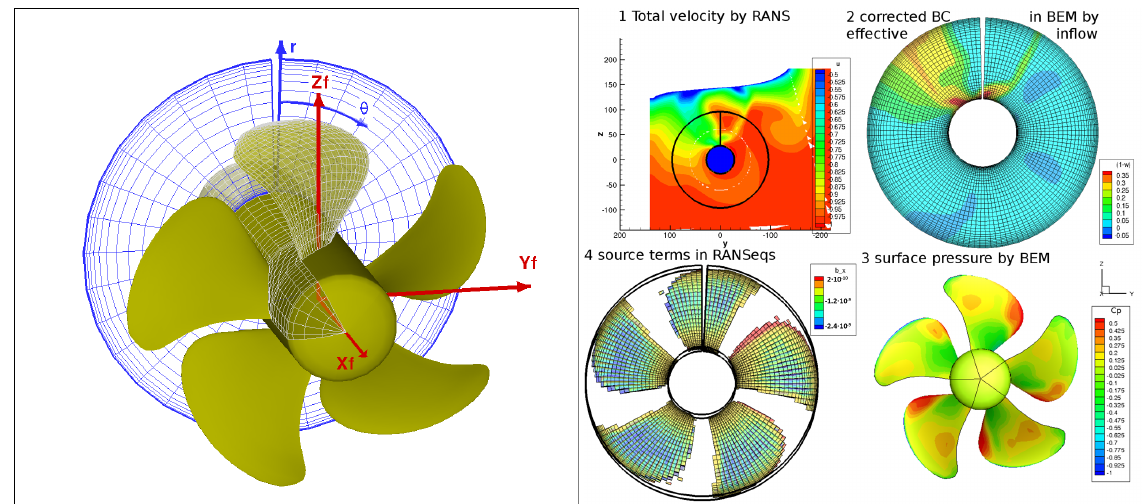
) used by the y z F F F